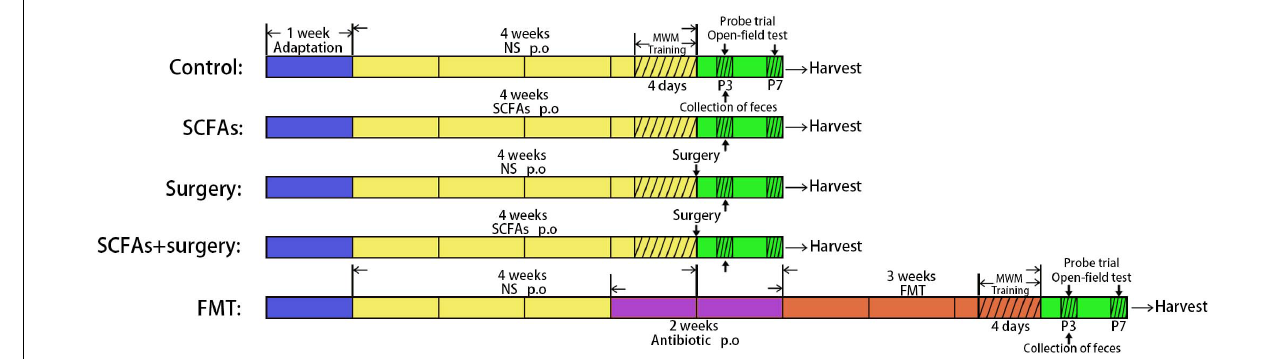
FIGURE 1 | The schedule of the present